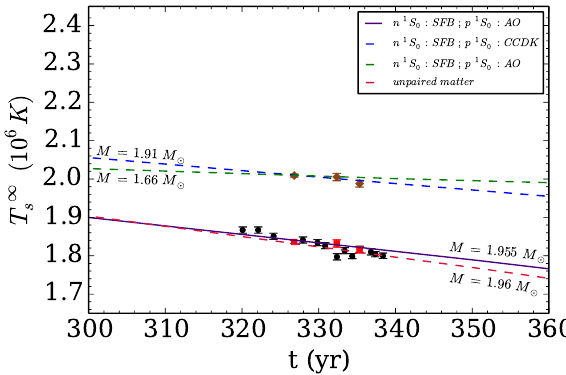
Figure 7. Temperature decrease rate for the NS in Cas A. The brown diamonds ( N H of 2006 [20]) and red squares ( N H of 2015 [60]) correspond to Chandra ACIS subarray mode data. Black circles indicate temperature measured using Chandra ACIS-S Graded spectra [21]. Fit results are shown in blue, green, purple, and